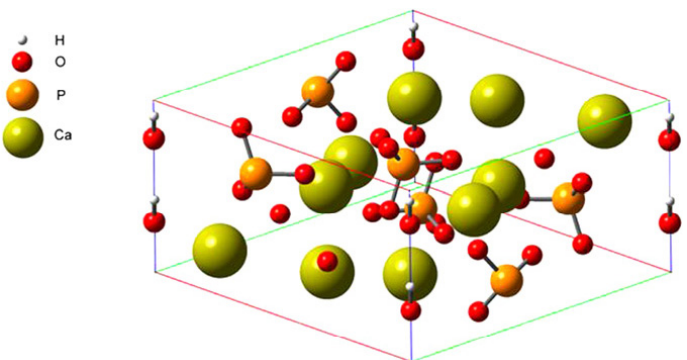
Figure 7. Schematic representation of a HAP unit cell